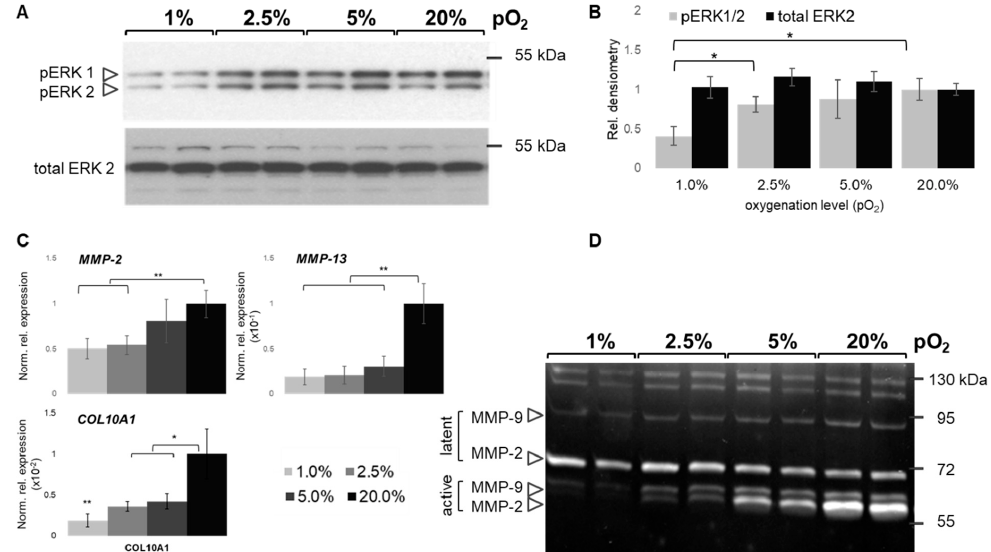
Figure 7. Oxygen ‐ dependent regulation of extracellular signal ‐ regulated kinase (ERK) and matrix metalloprotease (MMP) activity. Representative Western blots showing phosphorylated active ERK (pERK1/2; p44/42, respectively) and total ERK2 as loading control from two donors ( A ) next to densiometric signal quantification ( B ). Normalized relative gene expression levels of MMP ‐ 2 and selected hypertrophy markers MMP ‐ 13 and COL10A1 ( C ). Gelatin zymography ( D ) shows latent MMPs and respective gelatinolytic activity of active forms, mainly derived from gelatinases MMP ‐ 2 and MMP ‐ 9. MW, kDa, on right. Oxygen percentages (pO 2 ) as gray scales (light gray 1%, black, 20%). Representative images derived from pooled pellets are shown. RT ‐ qPCR ( n = 4), Western blot ( n = 3); zymogram ( n = 2); * p < 0.05, ** p < 0.01.